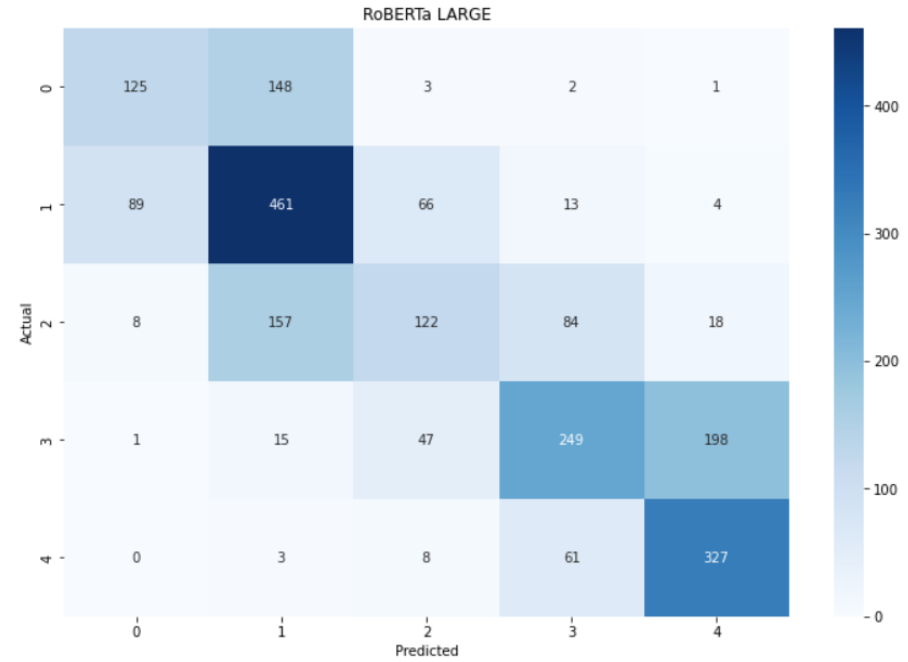
Figure 16. Confusion matrix for RoBERTa LARGE